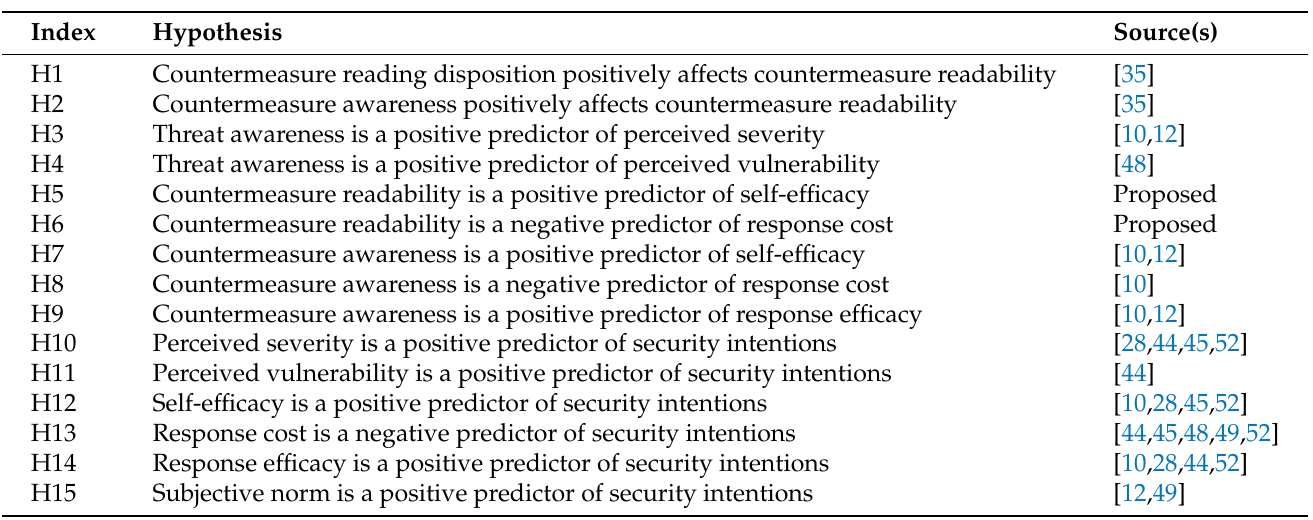
Table 1. List of hypotheses this paper